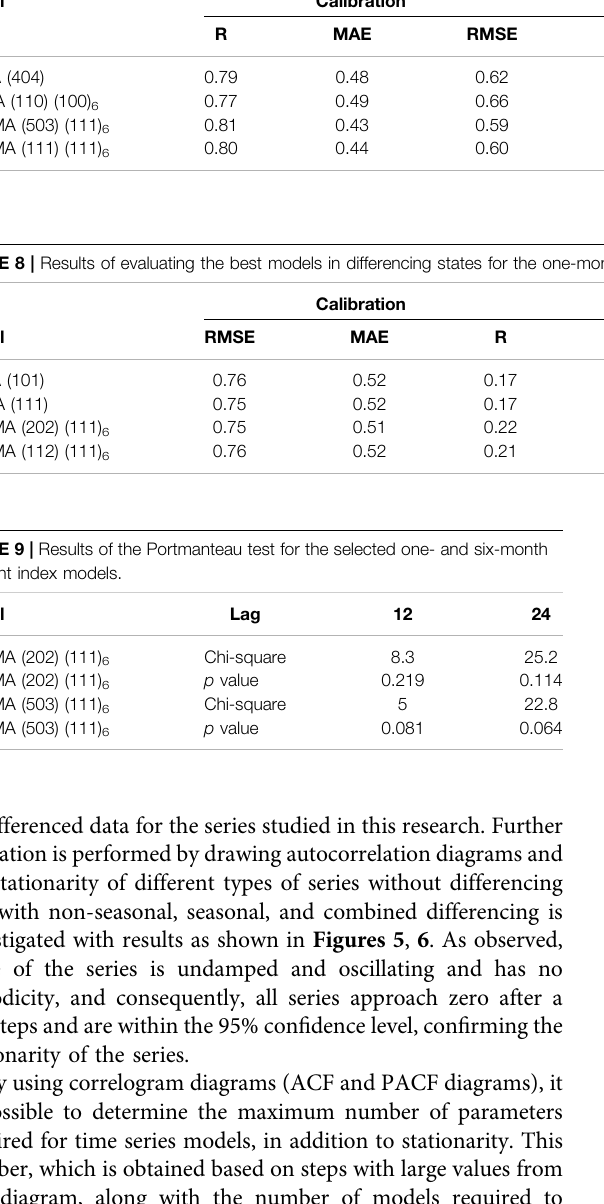
TABLE 7 | Results of evaluating the best models in differencing states for the six-month drought index. Model